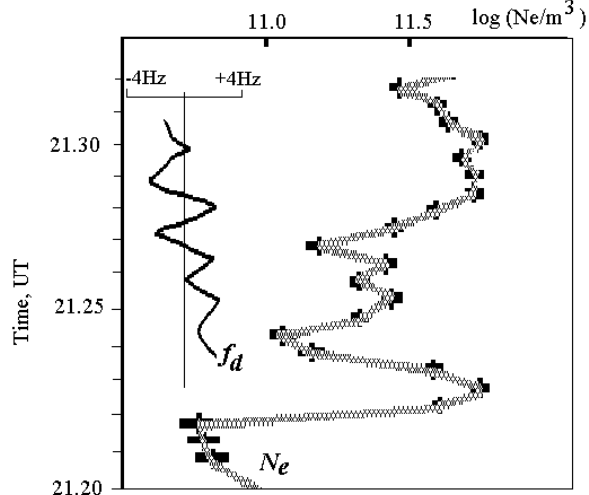
Fig. 2. Temporal variations of electron density N e at 150km alti- tude from Tromsø EISCAT UHF radar measurements and Doppler frequency variations f d characterizing track 3 on 16 February